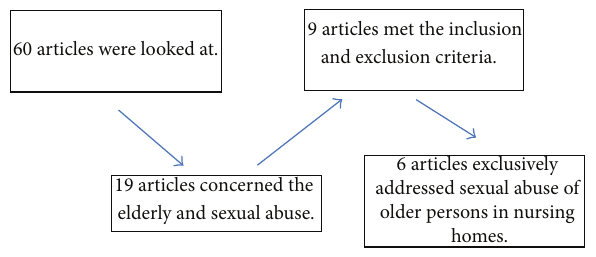
Figure 1: Phases of the selection of